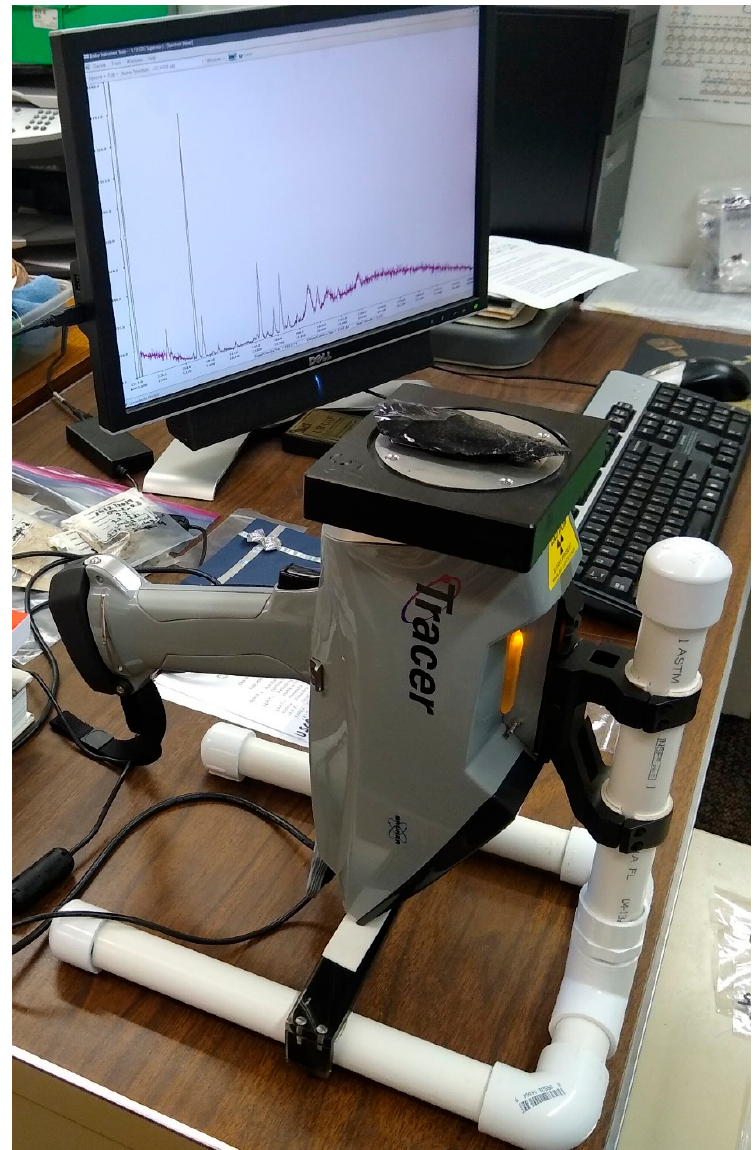
Figure 3. Most recent pXRF instrument (Bruker Tracer V g ) used in these studies. Mounted upright using a home-made plastic stand.